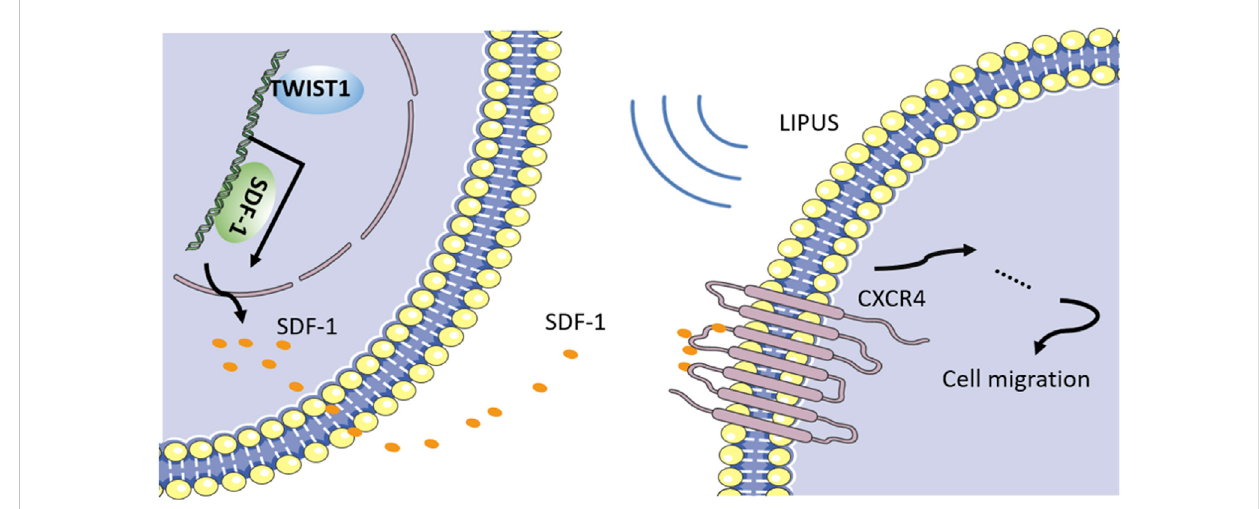
FIGURE 2 LIPUS promotes PDLSCs migration through SDF-1/CXCR4 signaling